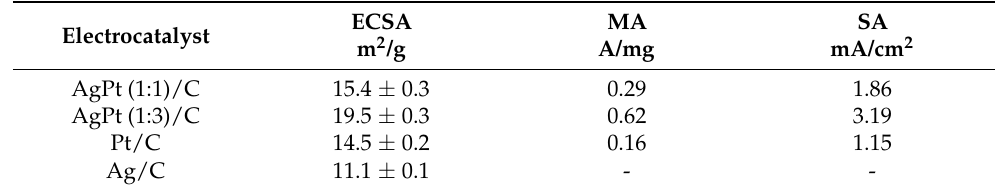
Table 1. Electrochemically active surface area, mass activity, and specific activity of the different